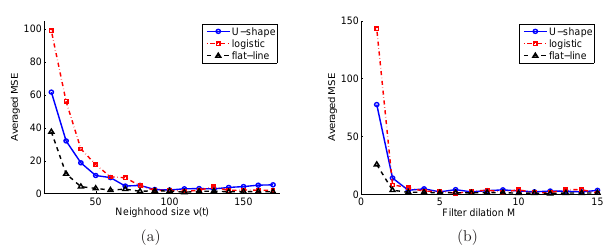
Figure 3: Normalized histograms of estimated C for (a) the LC method, (b) the GC 1 method, and (c) the GC 2 method are shown. The results are based on simulated mBm signals from the U-shape H ( t ) and true C = 3. The red dot represents its average of estimated C .